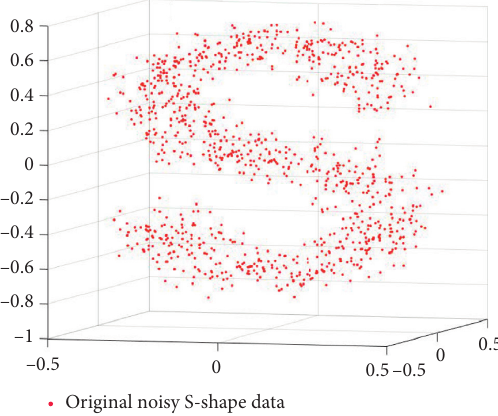
Figure 9: Visualization of noisy S-shaped